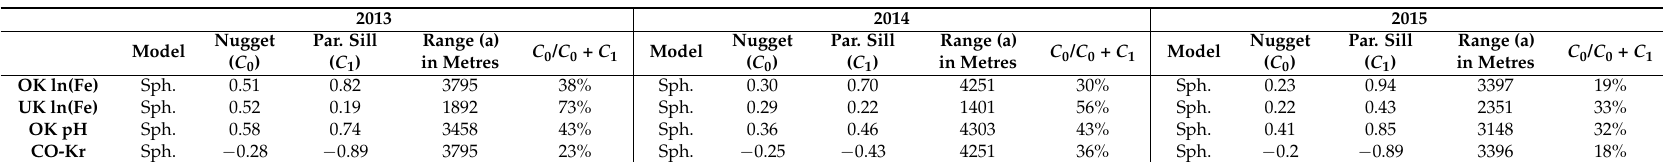
Table 3. The semivariogram models and parameters for the three interpolation methods for each year along with the cross-semivariogram parameters for Co-Kriging. The C 0 / C 0 + C 1 is the nugget to total sill ratio. Models were estimated from the training